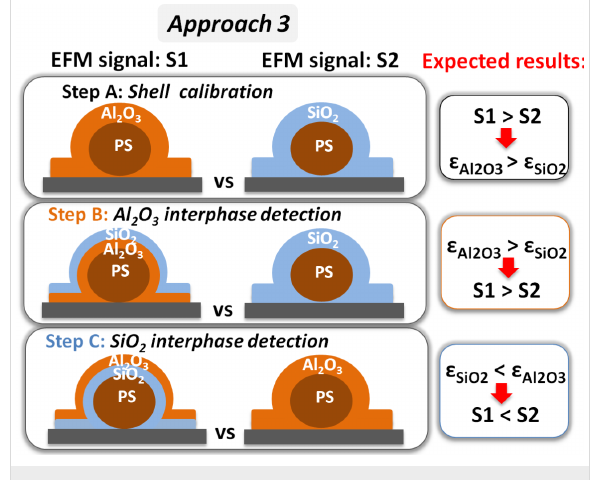
Figure 5: The three steps of approach 3: compared samples and methodologies.